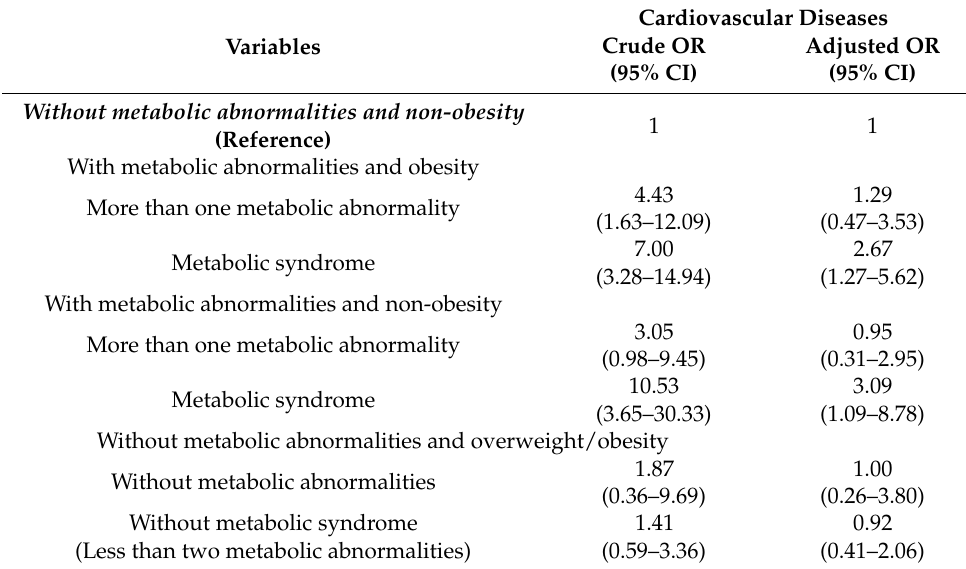
Table 2. Combined effects of metabolic abnormalities and obesity among Korean postmenopausal